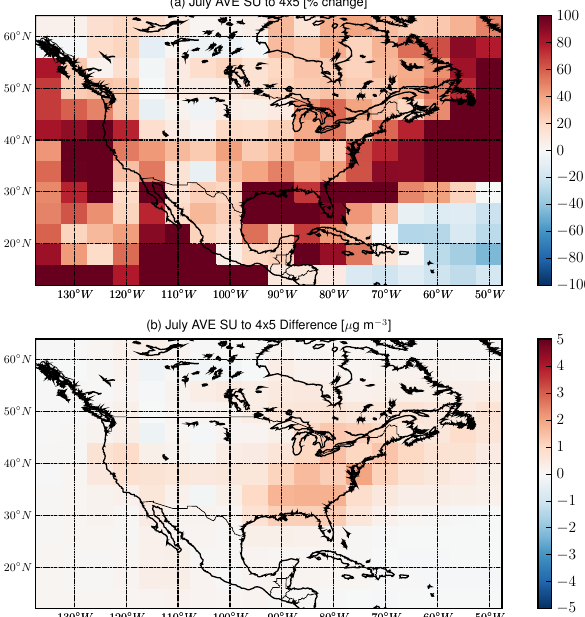
Fig. 6. SOA comparisons between the scaled up 0.5 ◦ × 0.667 ◦ sim- ulations (SU) and the 4 ◦ × 5 ◦ simulations averaged over July. Panel (a) is the % difference between the SU and 4 ◦ × 5 ◦ SOA and (b) is the absolute difference (µg m − 3 )